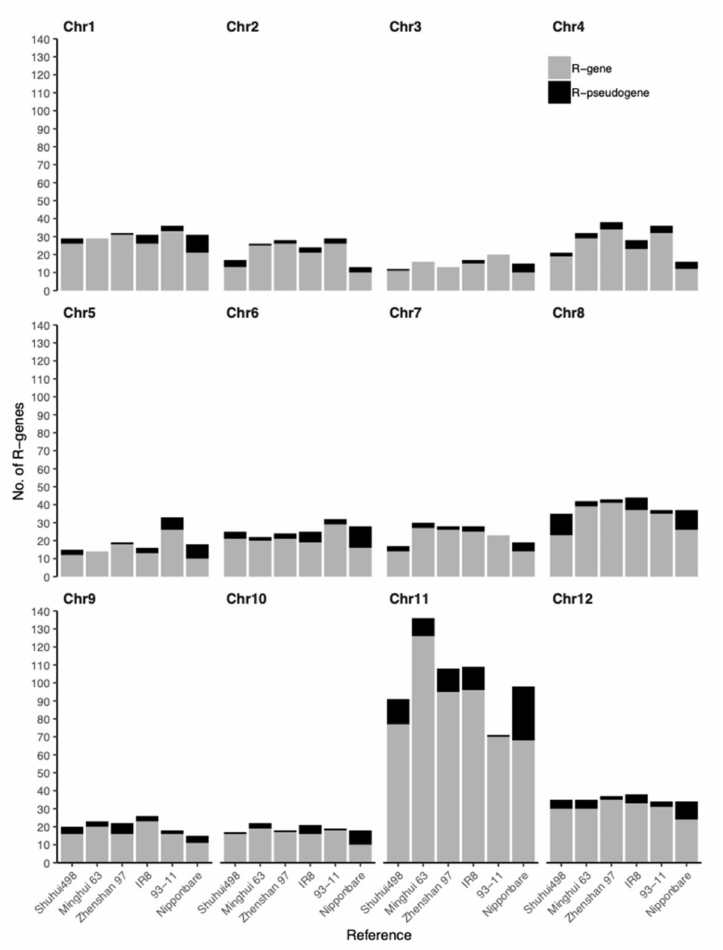
Figure 2. Number of R-genes and R-pseudogenes identified on each chromosome of the six reference genomes